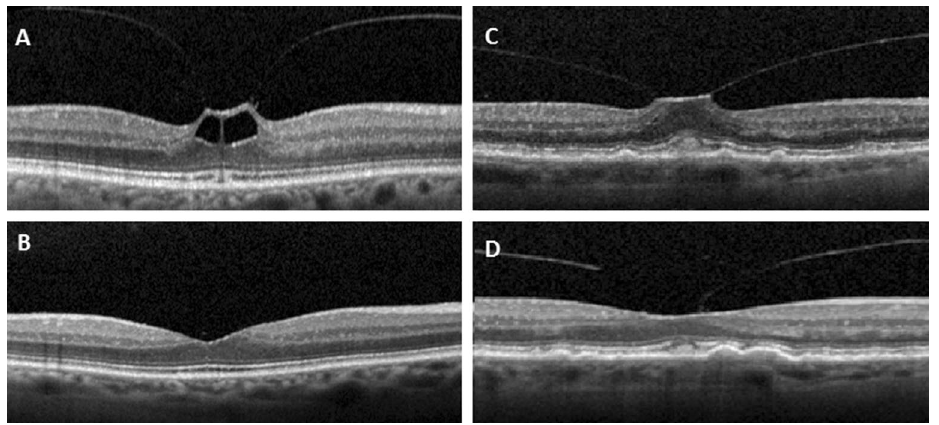
Figure 1. VMT preoperative and one month after C3F8 injection. From top to bottom: complete VMT release ( A , B ), partial VMT release with persistent VMA ( C , D ). VMT vitreomacular traction, VMA vitreomacular